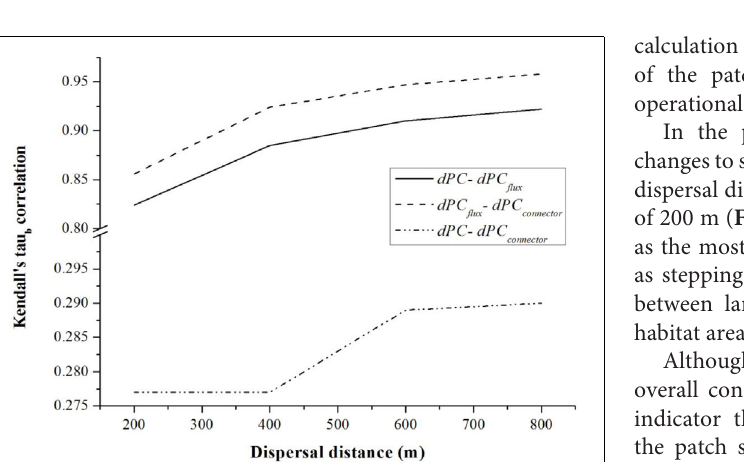
FIGURE 4 | Kendall’s rank correlations ( tau b ) between the patch importance indices (dPC, dPC flux , dPC intra , dPC connector , ) and patch area with increasing dispersal distance.